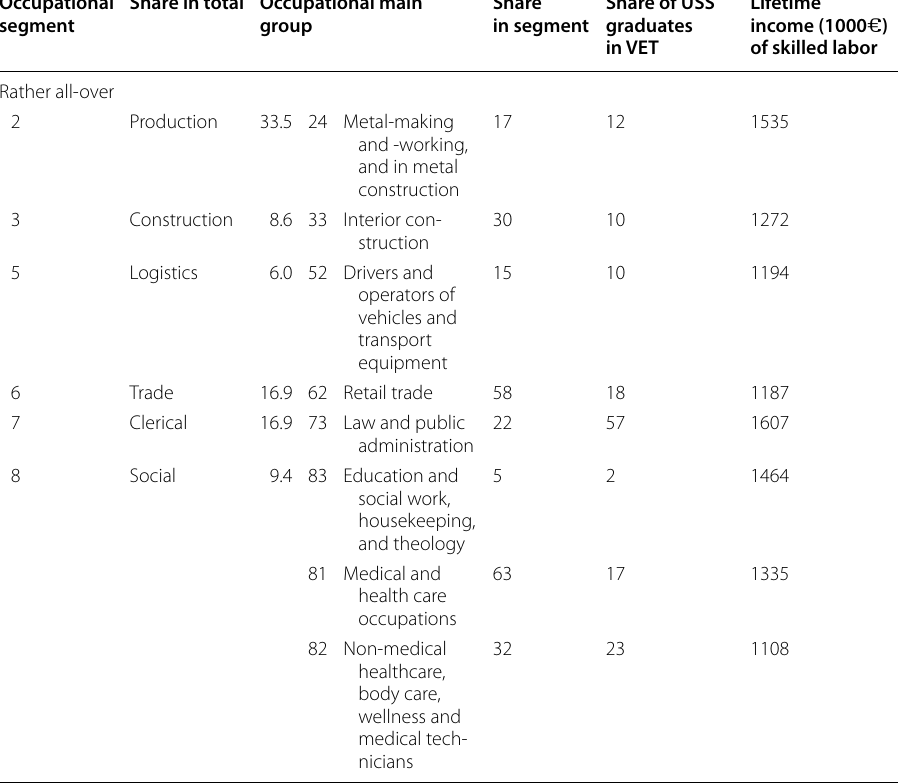
Table 2 Characteristics on segment level by weighted group characteristics